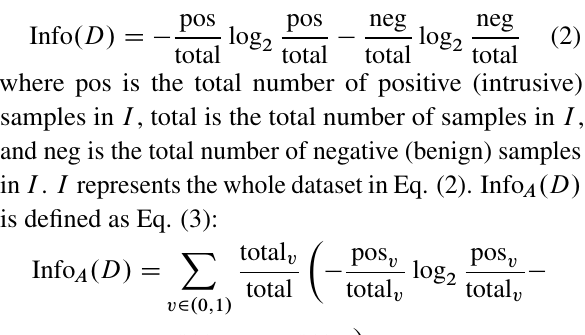
Fig. 1 Flow chart for building BDHDLS, where FC represents Full Connected feed forward neural